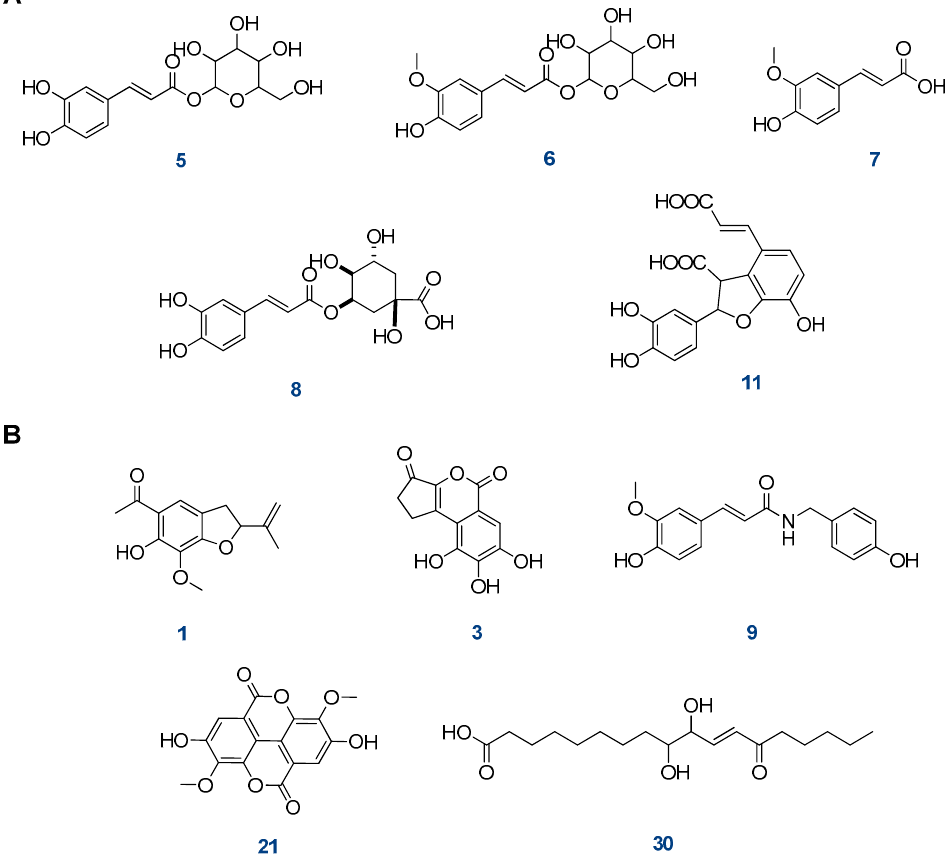
Figure 5. The structure of the tentatively identified compounds in the dichloromethane fraction of S. hispanica L. aerial parts. ( A ) Phenolic acid derivatives, ( B ) miscellaneous compounds. Compound 5 (Rt, 9.00 min) showed a precursor ion at m / z 343 [M+H] + that was successively subjected to the loss of the hexose sugar moiety to form a fragment ion at m / z 181 [caffeic acid+H] + . Therefore, the compound ( 5 ) was identified as caffeic acid hexoside